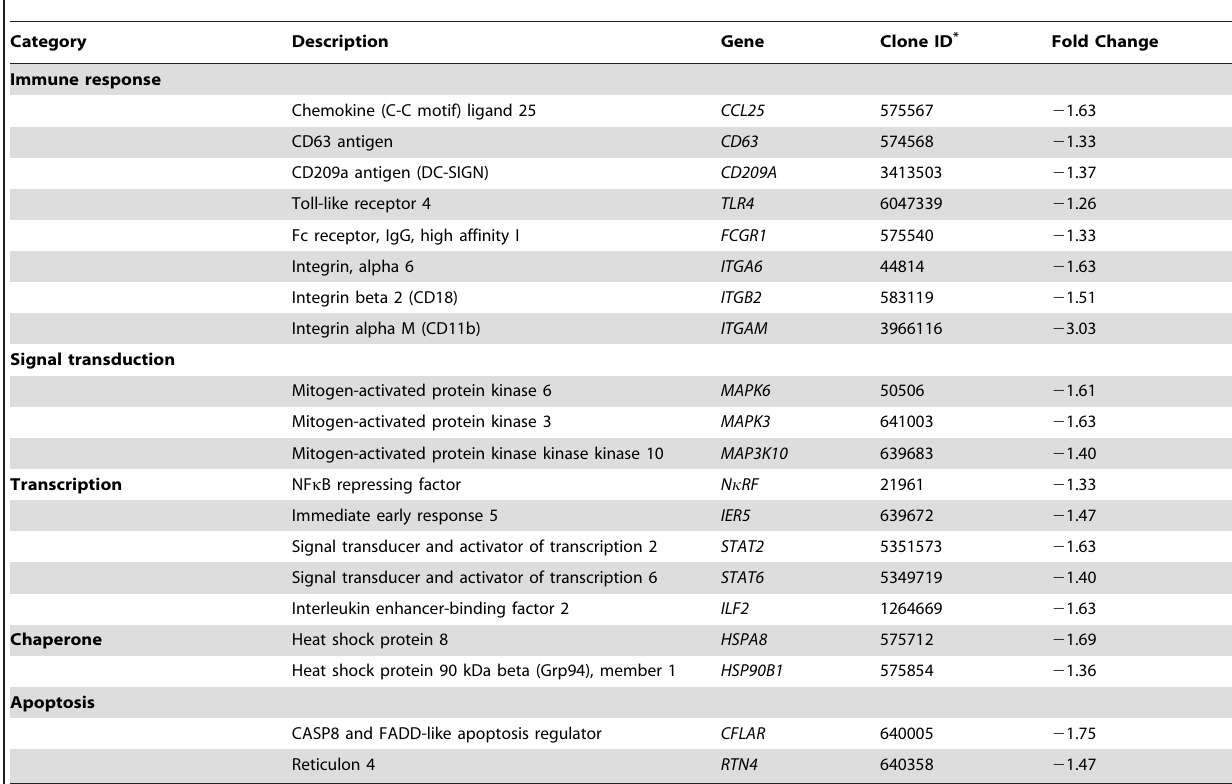
Table 2. Selected genes down-regulated in murine dendritic cells after 6 h of infection with P. brasiliensis .